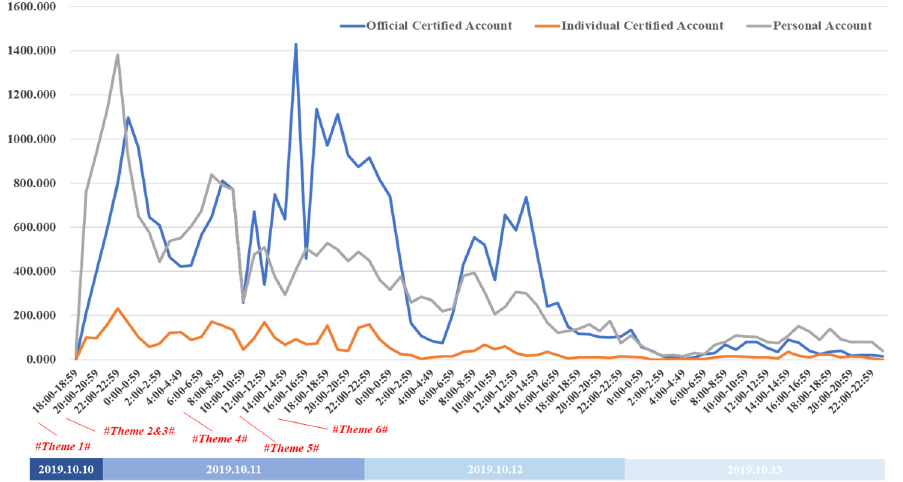
Figure 6. Number of messages posted by the different user groups.